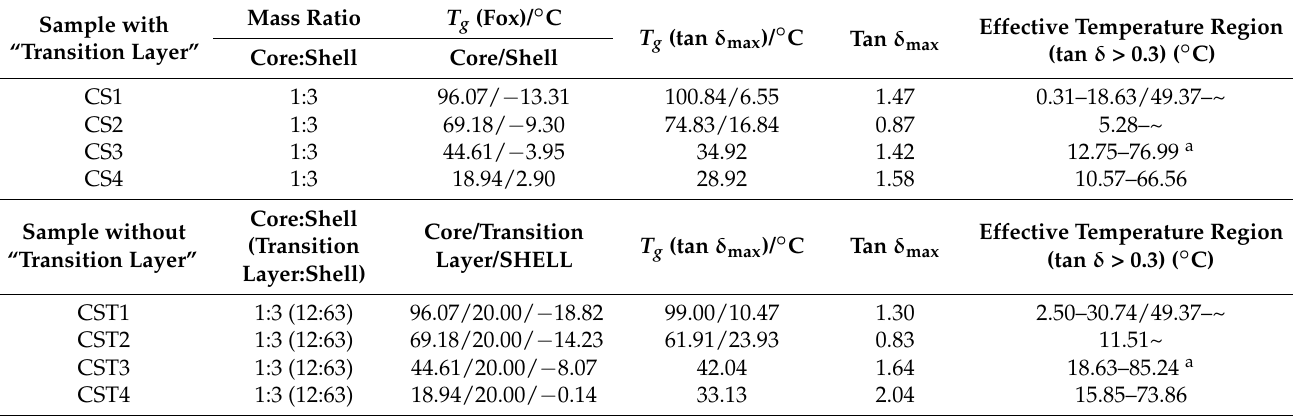
Table 4. The damping properties of synthesized latex